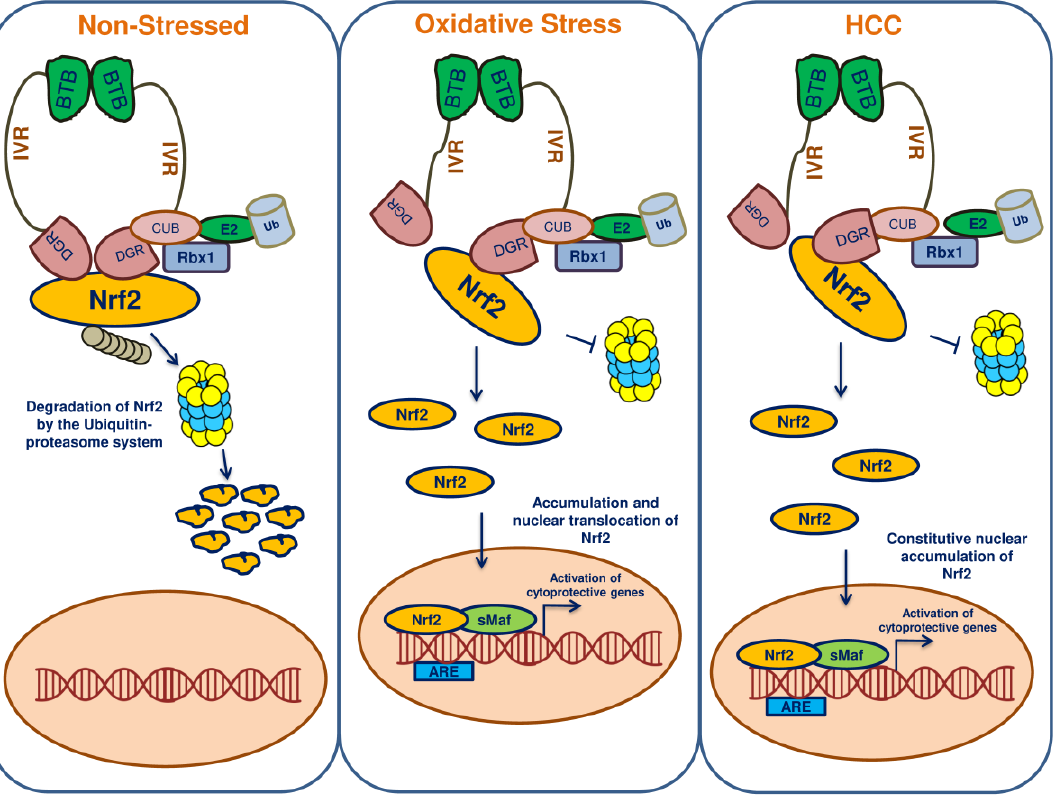
Figure 2. Keap1-Nrf2-ARE pathway in non-stressed, oxidative stress state and HCC cells. Keap1 has three characteristic domains: BTB, IVR and DGR domains. In the unstressed condition, Keap1 promotes Nrf2 degradation so that the level of Nrf2 remains very low. During oxidative stress, Nrf2 gets activated to maintain redox homeostasis. In HCC, sustained Nrf2 activation leads to cellular proliferation and resistance against drugs.